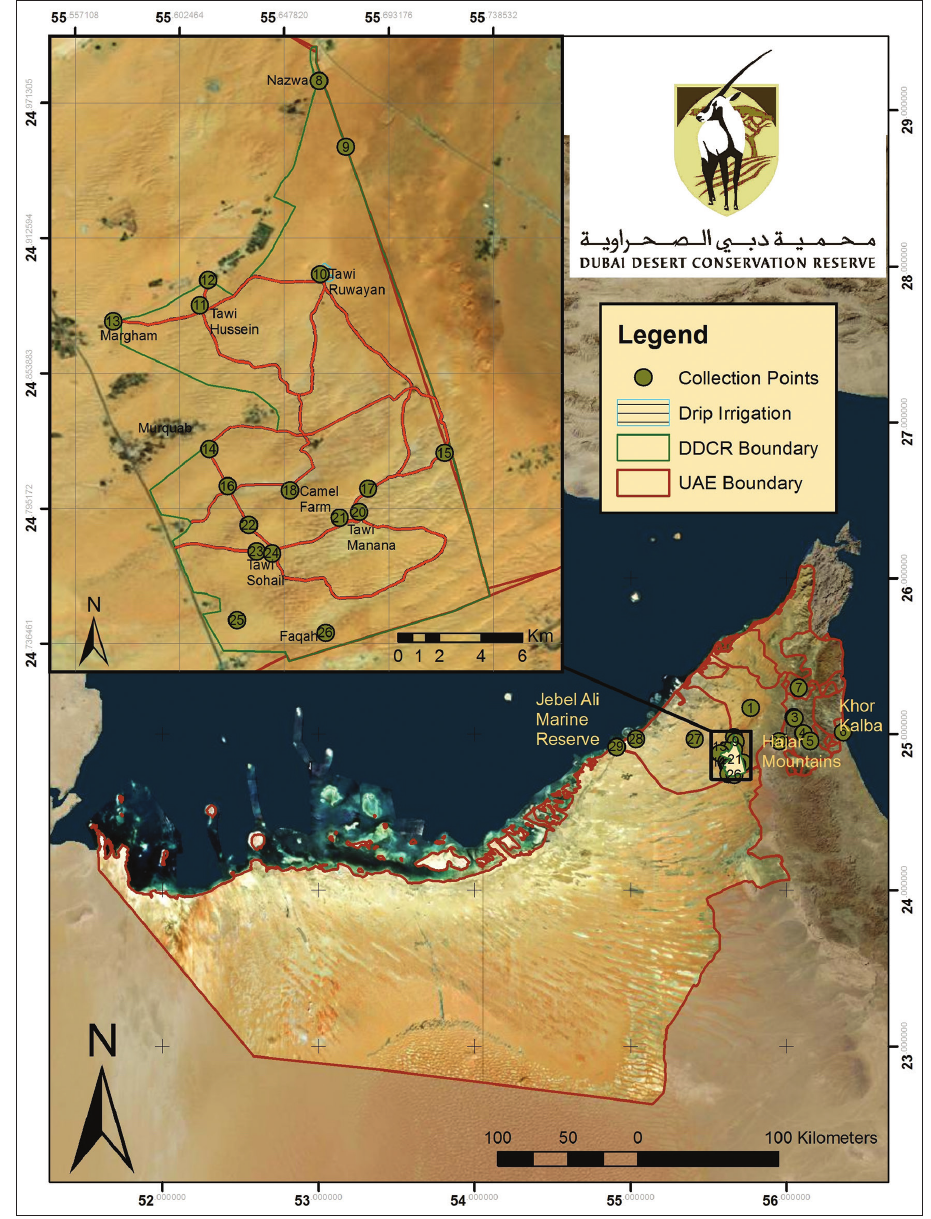
Figure 1. Map of the UAE with inset enlargement of the DDCR, giving the positions of the collection sites.